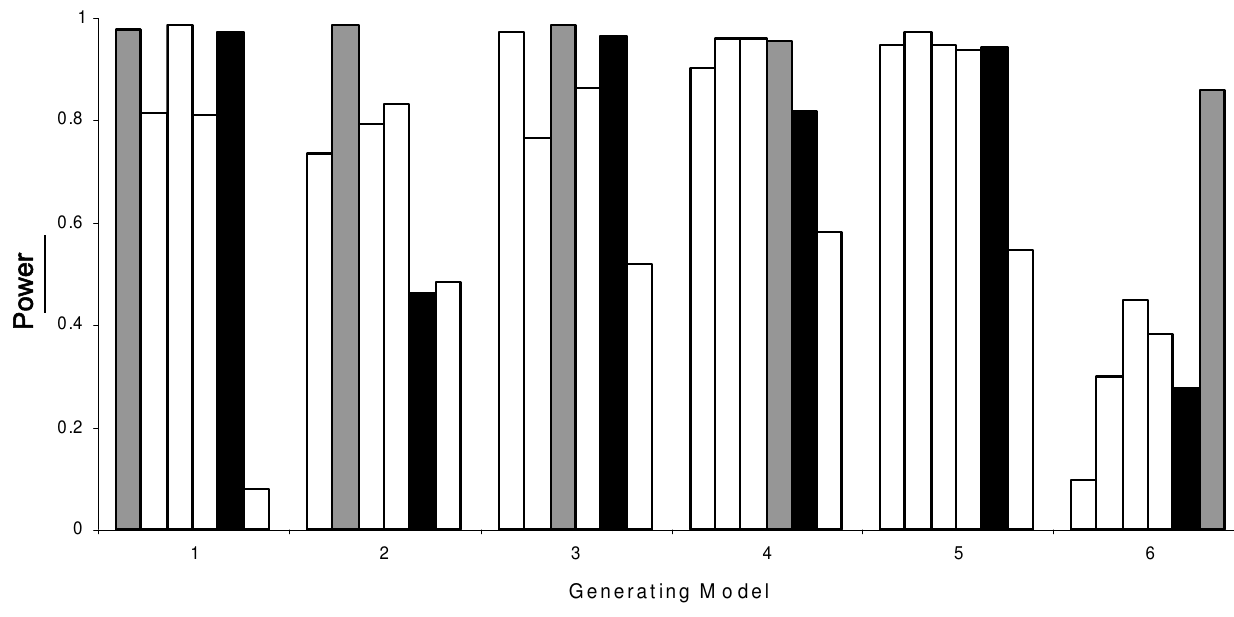
Figure 4 Power of each analysis model under each generating model for the logistic model averaged across all allele fre- quencies and heritability estimates. Models 1–6 are presented in order from left to right for each generating model. Model 5 (black bar) has similar power to the generating model (grey bar) in nearly all